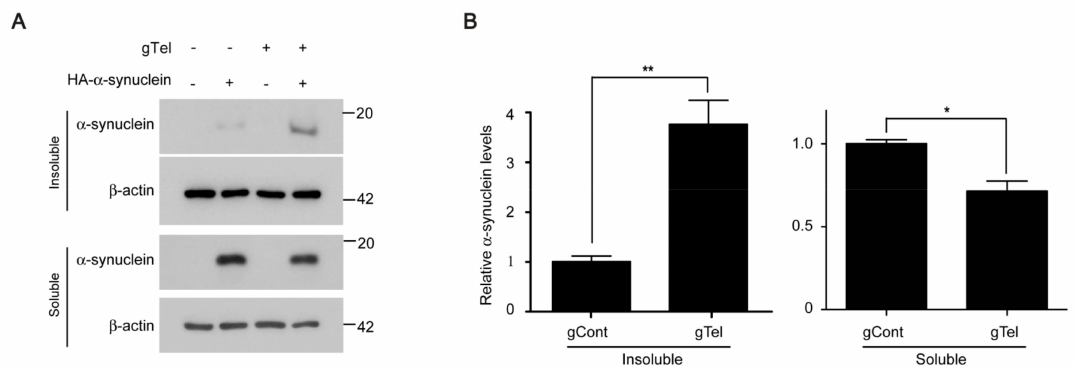
Figure 5. Redistribution of α -synuclein into insoluble fraction by CRISPR-Cas9 mediated telomere removal ( A ) Representative Western blots of α -synuclein expression in 1% Triton X soluble and insoluble fractions from SH-SY5Y cells transfected with the indicated combinations of HA- α -synuclein, gTel, and gCont constructs (72 h); ( B ) Quantification of relative amounts of α -synuclein expression in insoluble or soluble fractions normalized to β -actin internal loading control ( n = 3 per group). Quantified data are expressed as mean ± SEM. Statistical significance was determined by unpaired two-tailed Student’s t test, * p < 0.05, and ** p <